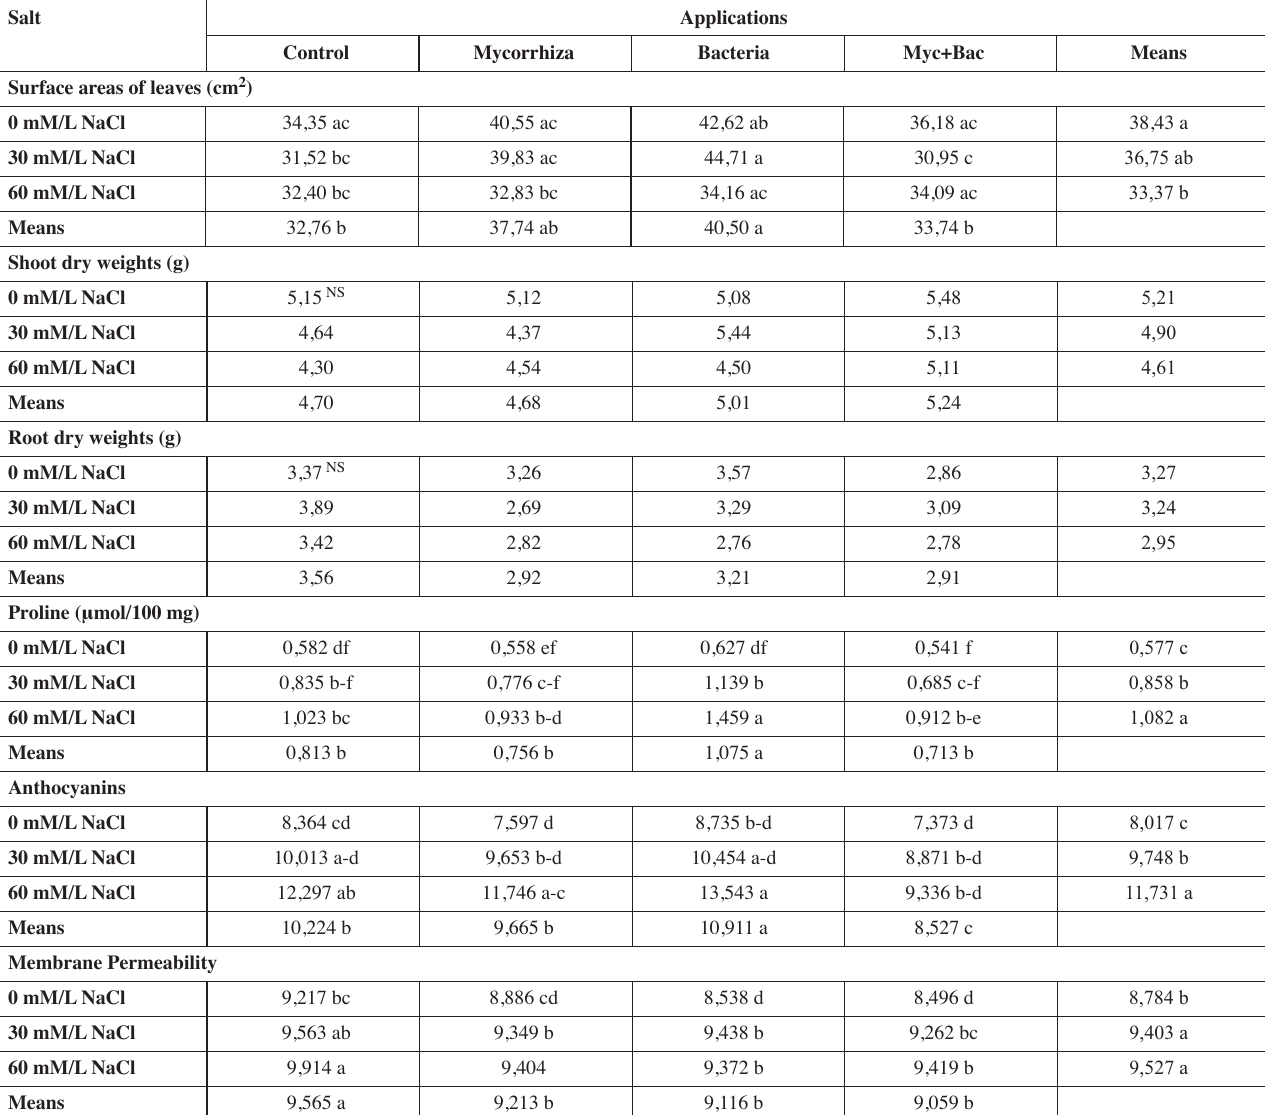
Tab. 2: Surface areas of leaves, shoot and root dry weights, proline, anthocyanins and membrane permeability in the leaf tissues of strawberry ‘San Andreas’ plants under salt (0, 30 and 60 mM/L NaCl) stress and applications (control, mycorrhiza, bacteria and myc+bac).